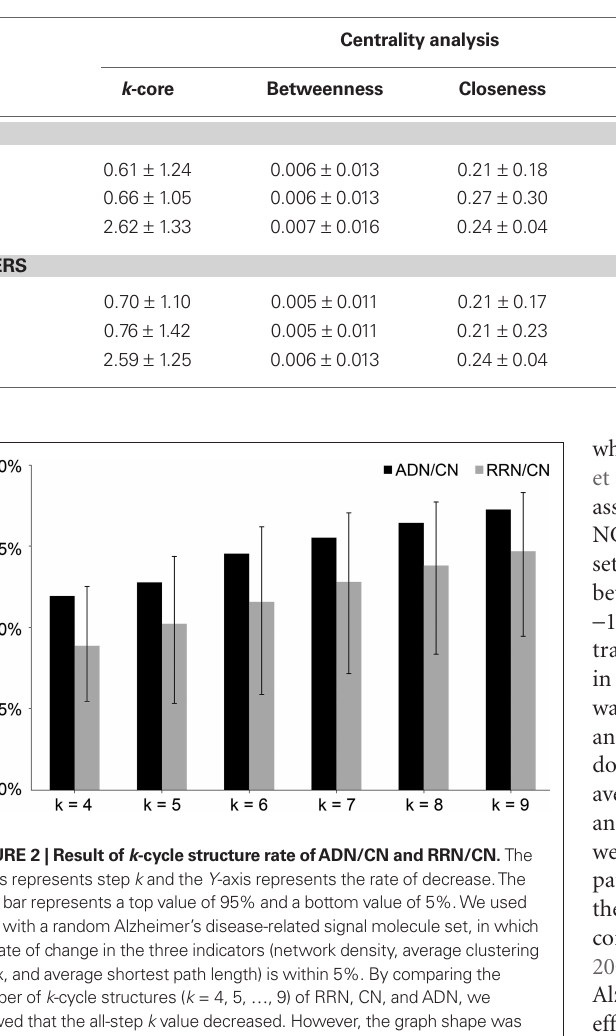
Table 2 | Network feature analysis of signal molecules. Network feature analysis of Alzheimer’s disease-related signal molecules and other signal molecules in the network (“Others”) performed by measuring k -core, betweenness, closeness, degree, change in average shortest path length, and change in articulation points (mean ± SD). There were no signifi cant differences in these measurements between Alzheimer’s disease-related signal molecules and other signal molecules in the network ( P < 0.05, Mann–Whitney U -test). This network feature is the same as that of disease-related molecules defi ned in earlier studies. IN means the incoming paths OUT means the outgoing paths, and ALL means both incoming and outgoing paths.